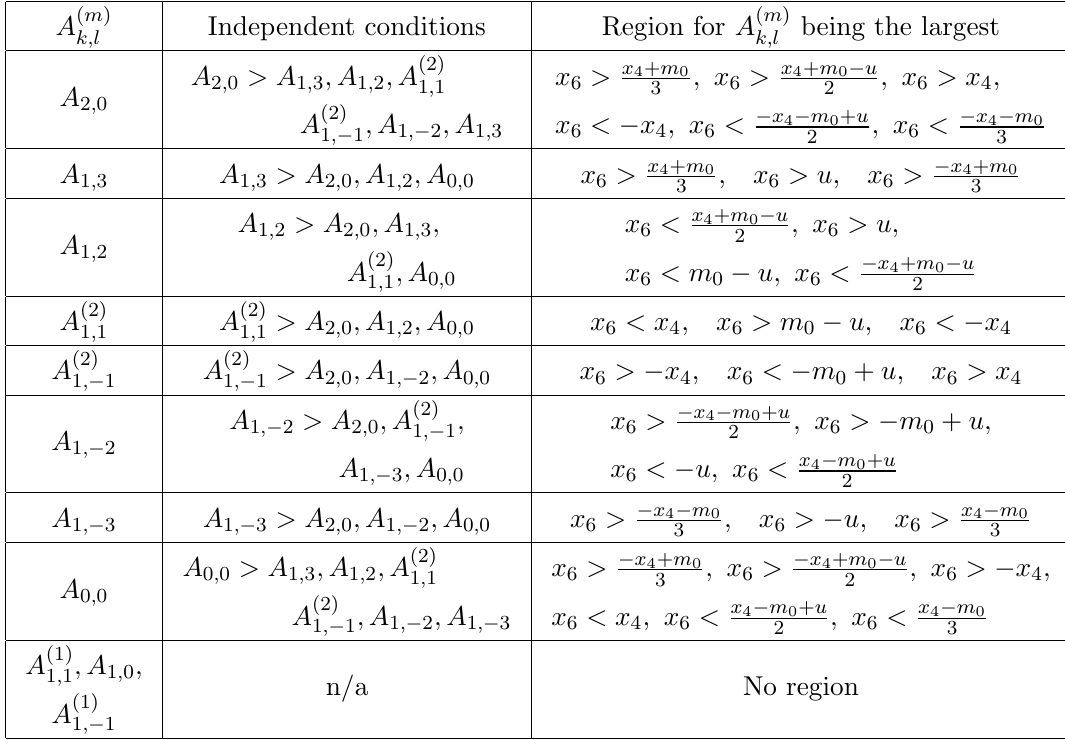
0 ) ’s for Region 3 (3.12) k 0 ;l 0 in the (cid:12)rst k;l